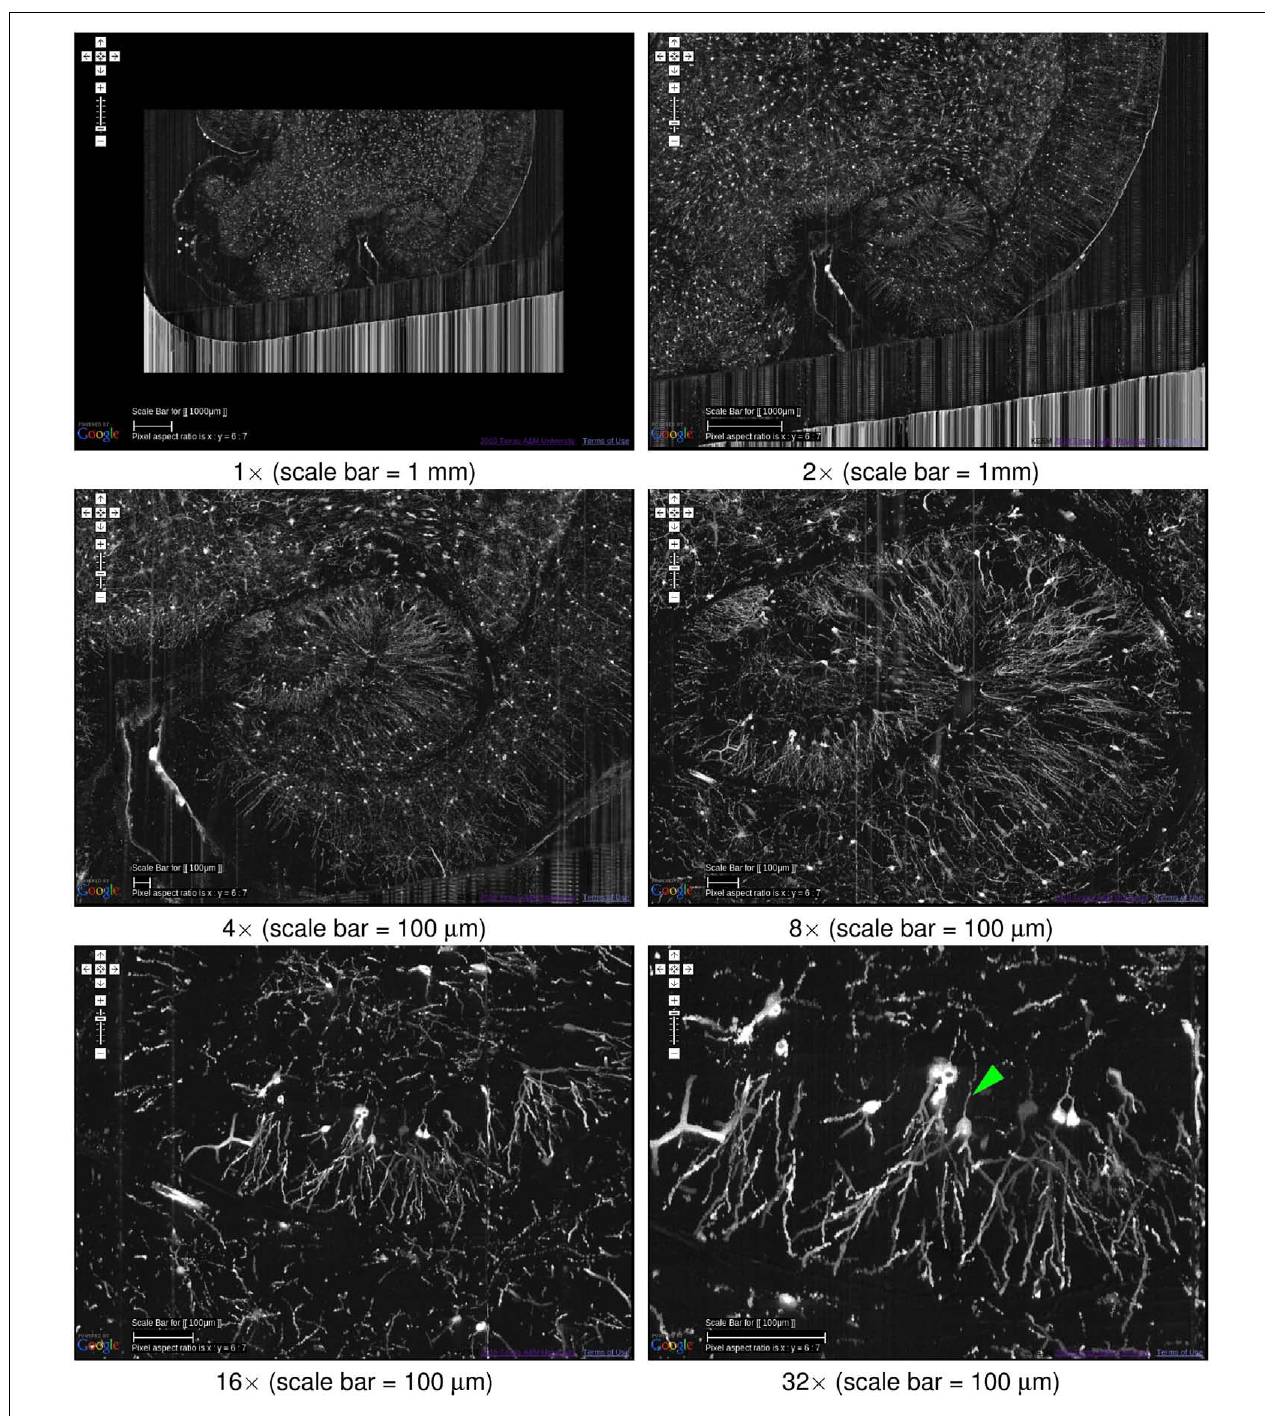
All panels show an overlay of 20 sections.The first four panels are shown with an overlay interval of 5 and the last two with an interval of 1. Axons emerging from the hippocampal neurons are clearly visible (arrow head, last